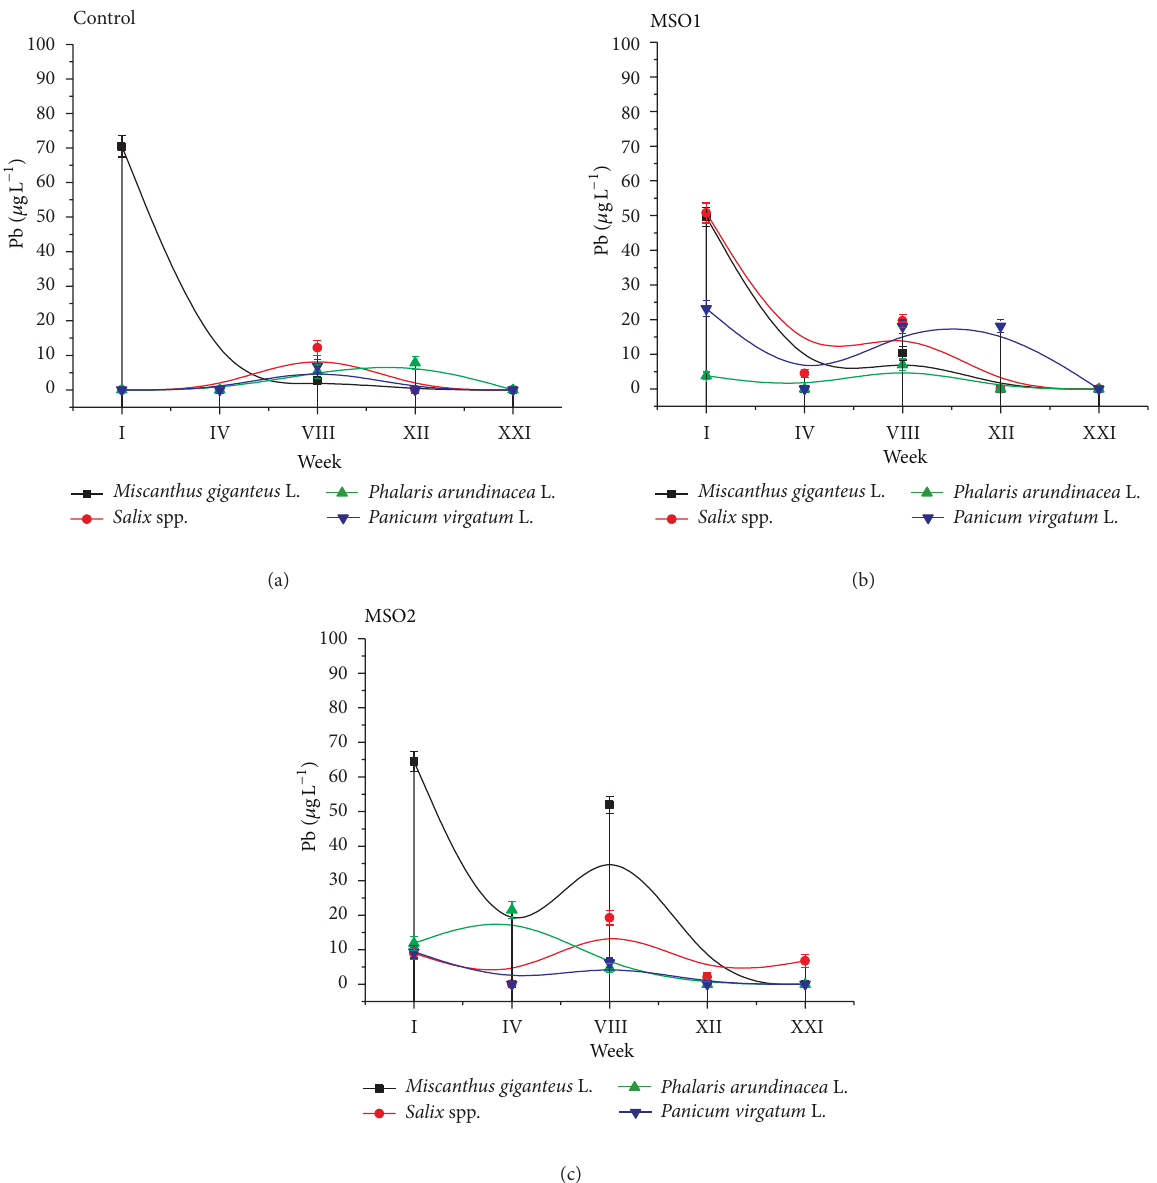
Figure 2: The content of Pb ions in soil leachate after the application of Trichoderma -based materials (MSO1 and